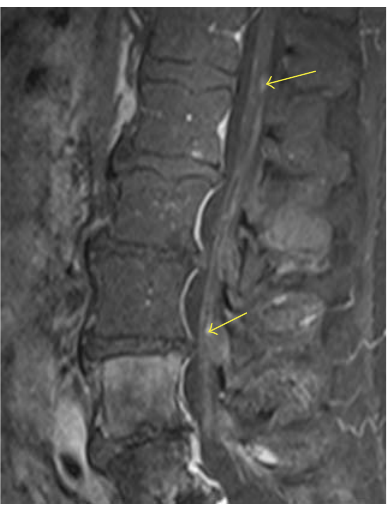
Figure 12: Sagittal contrast-enhanced T1-weighted MR image with fat saturation reveals multiple small enhancing lesions (yellow arrows) along the cauda equina, related to leptomeningeal carcino- matosis in a patient with breast cancer.